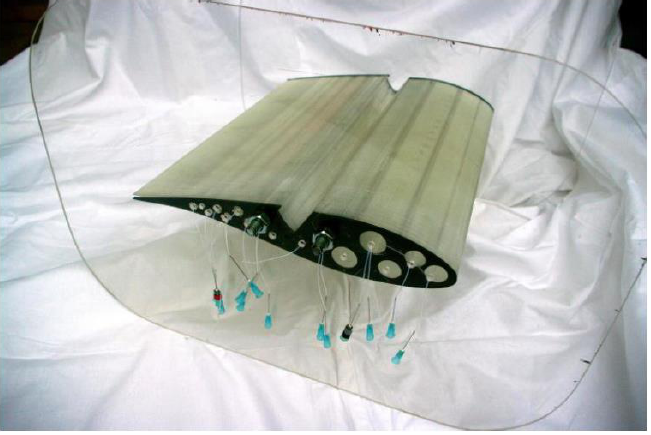
Figure 13. Risø airfoil with cavity A—model prepared for visualization tests.